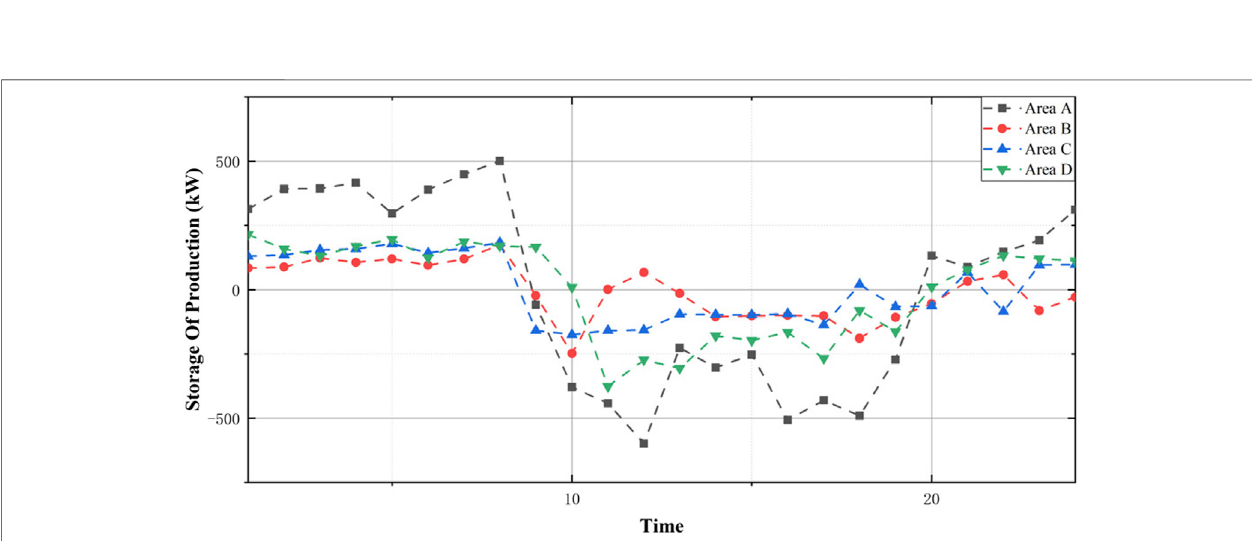
FIGURE 10 | The optimal storage of production strategy of generation & storage